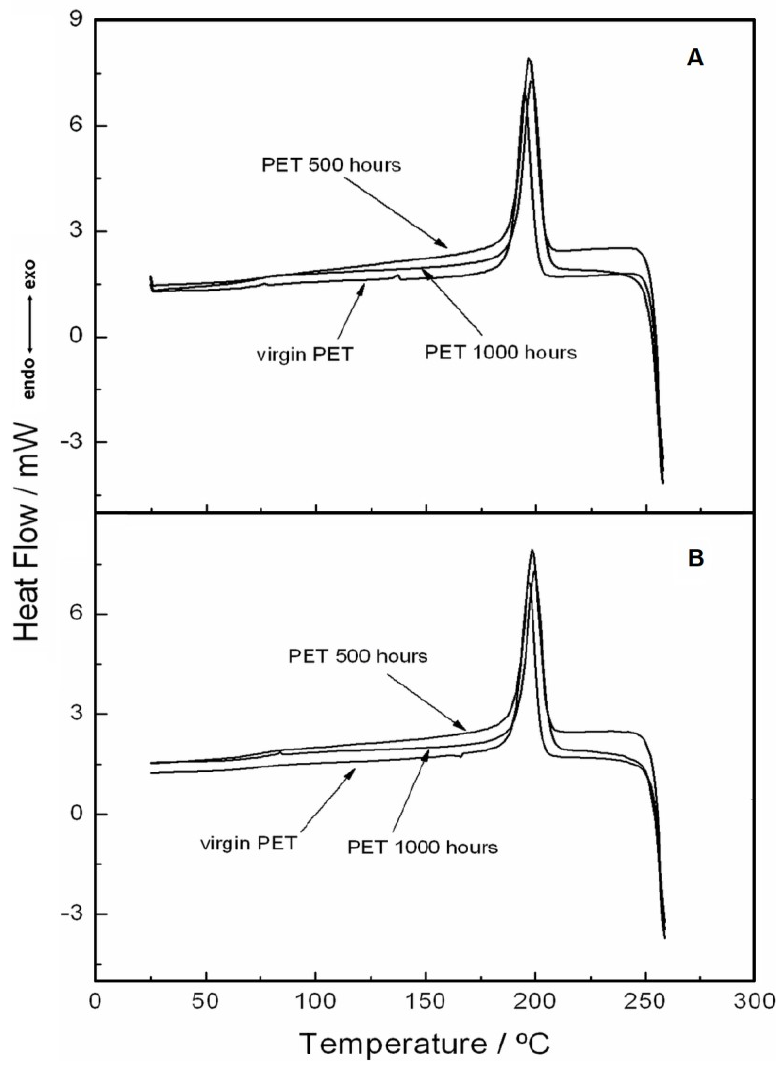
Figure 11. DSC curves with a cooling rate of 20 °C·min − 1 under a nitrogen gas purge with a flow of 50 mL min − 1 in an aluminum crucible with sample masses around 2 mg: ( A ) first cooling and ( B ) second cooling.